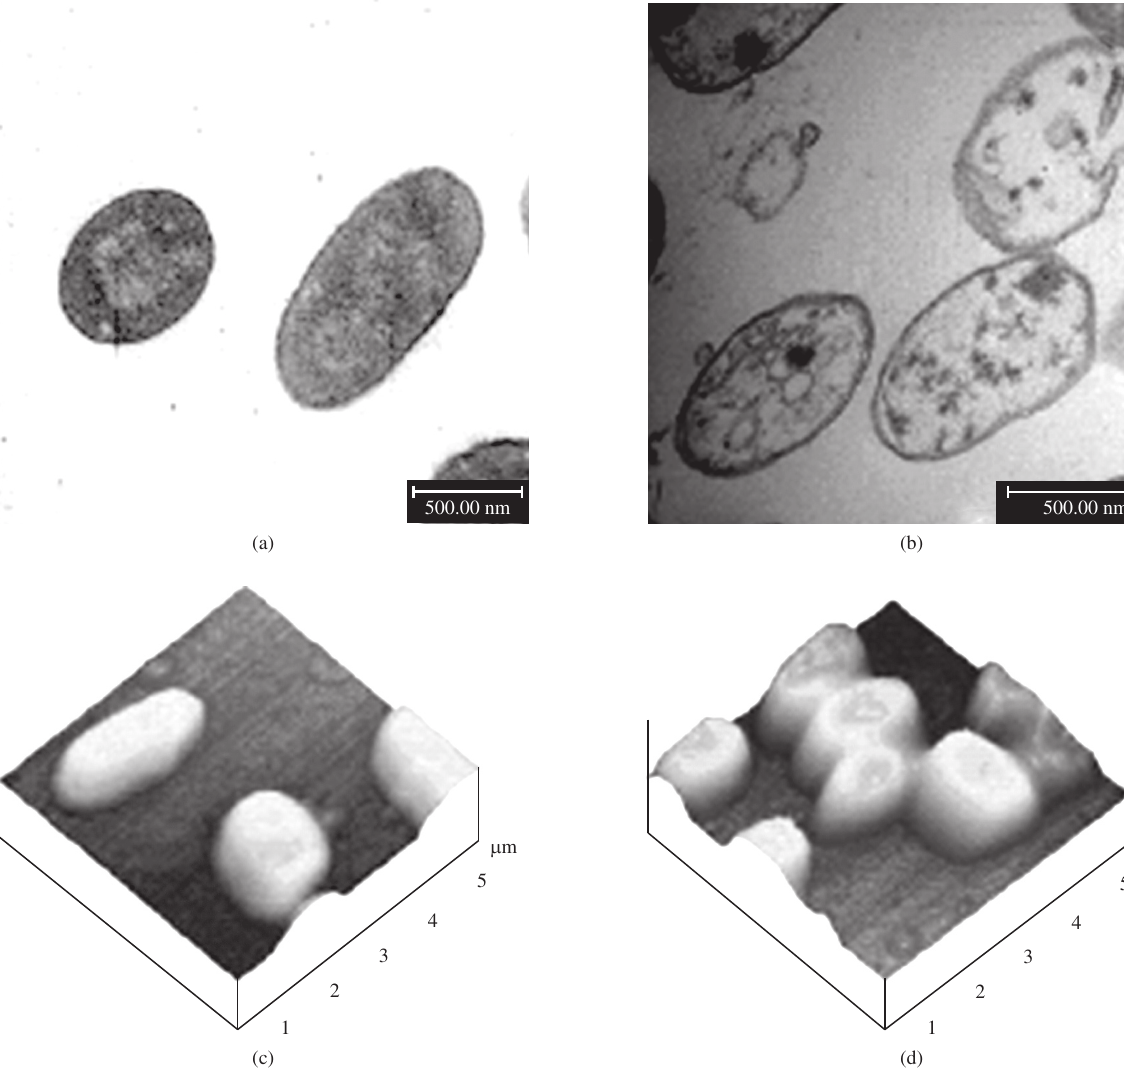
Figure 6. Morphological change of E. coli cells resulting from the electrolysis at 100 mA.cm –2 for 5 minutes; [ E. coli ] pH = 7.1, 25 °C. a) before electrolysis (TEM); b) after electrolysis (TEM); c) before electrolysis (AFM); and d) after electrolysis (AFM) 43